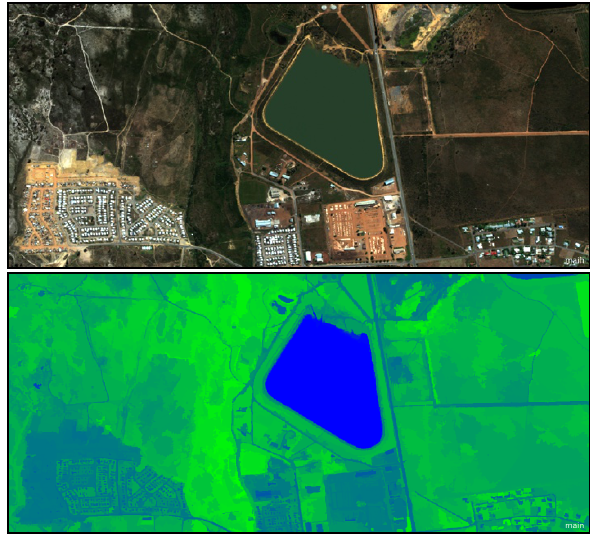
Figure 5. NDVI using density slicing WorldView-2 Image Copyright 2014, DigitalGlobe